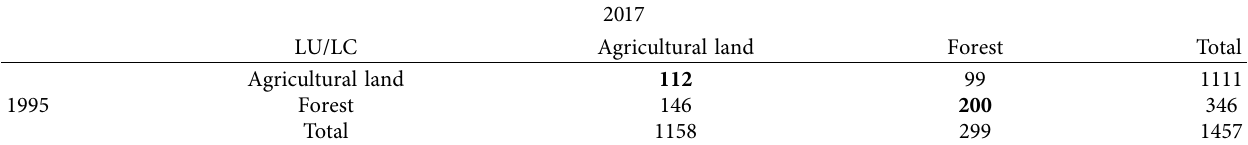
Table 7: Land use/land cover change matrix (ha) between 1995 and